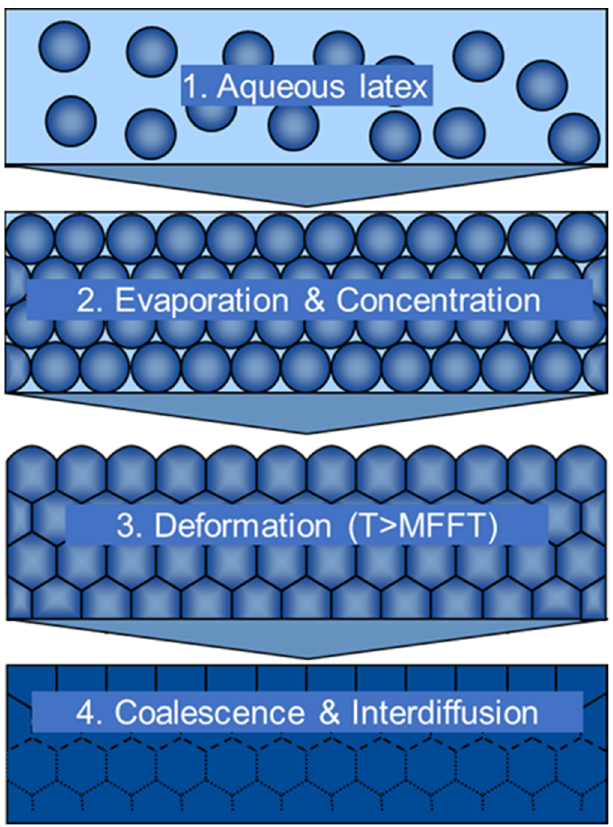
Figure 2. Stages of film formation for latex particles. T is the temperature during the film formation. MFFT is the minimum film formation temperature of the latex.